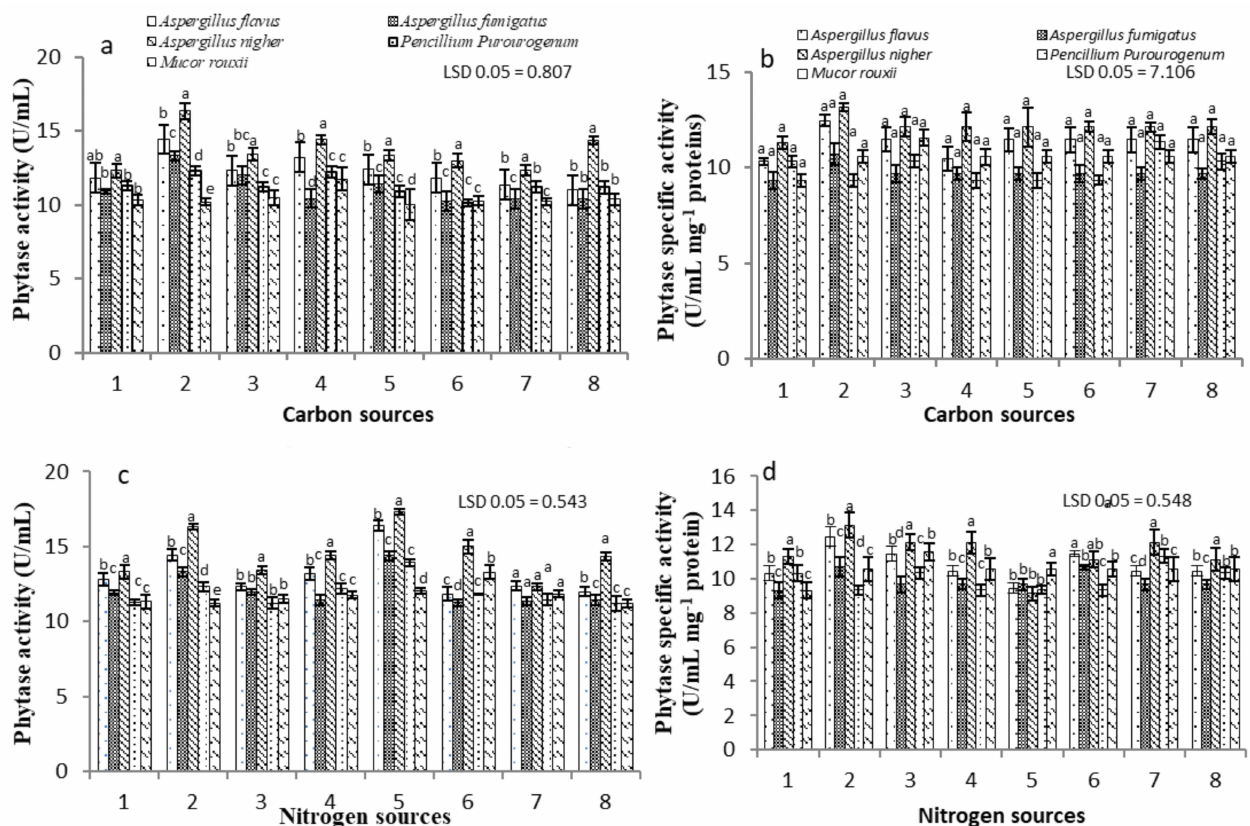
Figure 4. Effect of various culture medium additives, such as carbon (1–8), lactose, glucose, galactose, maltose, fructose, sucrose, xylose, and starch; and nitrogen sources: (1–8) casein, yeast extract, sodium nitrate, urea, ammonium nitrate, ammonium sulfate, and sodium nitrate, respectively, on phytase activity ( a , c ) and phytase specific activity ( b , d ) of selected fungi ( Aspergillus niger , Aspergillus flavus , Aspergillus fumigatus , Penicillium purourogenum, and Mucor rouxii ) having inherent phytase production potential. The given LSD value at 0.05 level refers to the significant differences among mean values of each